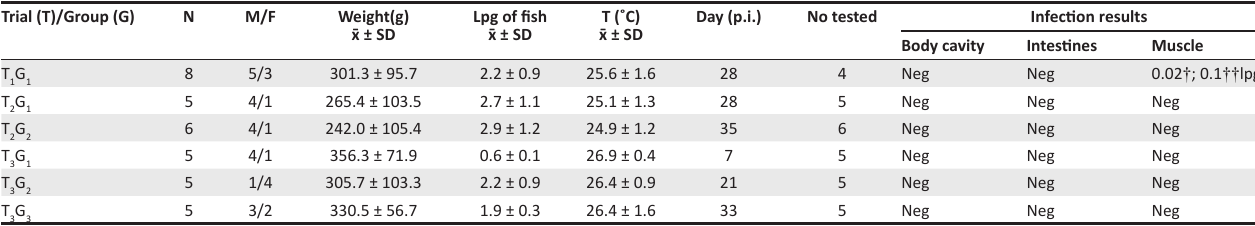
TABLE 2: Results from experimental infection of tigerfish ( Hydrocynus vittatus ) with Trichinella zimbabwensis. Trial (T)/Group (G) N M/F Weight(g)